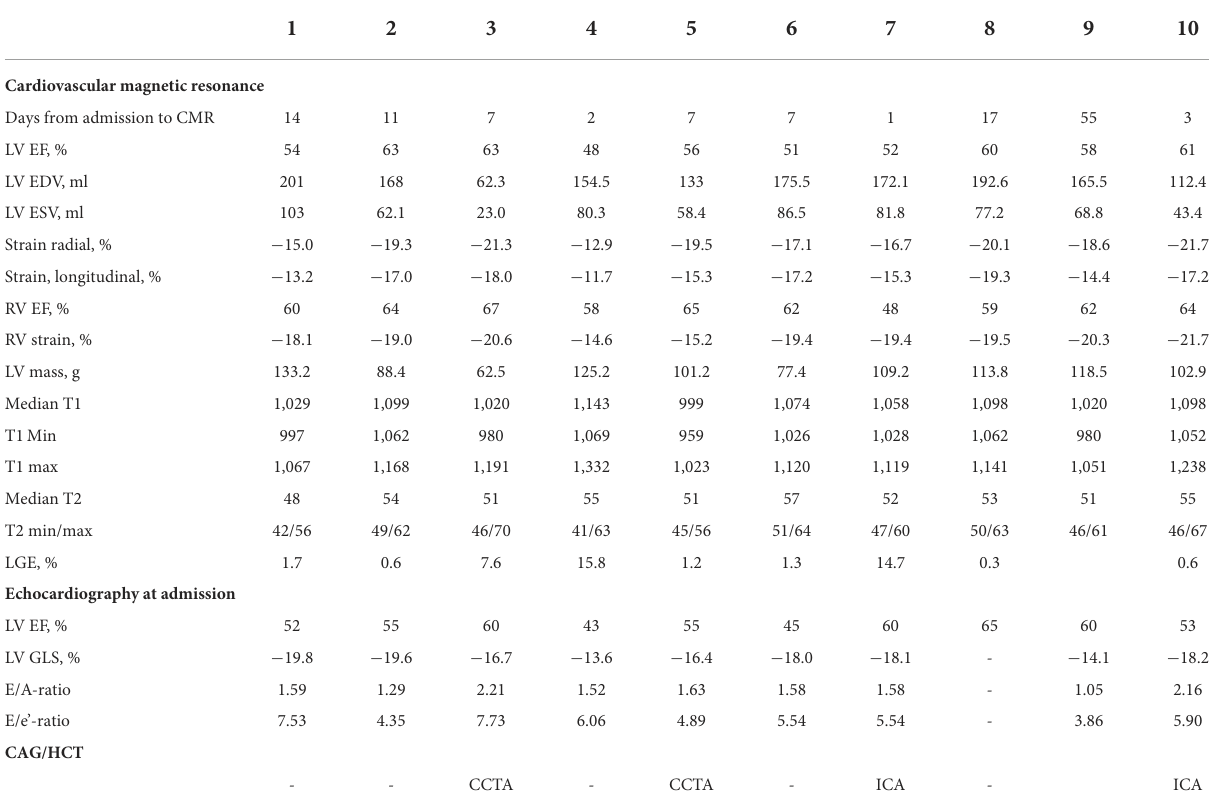
TABLE 2 Cardiovascular magnetic resonance and echocardiographic